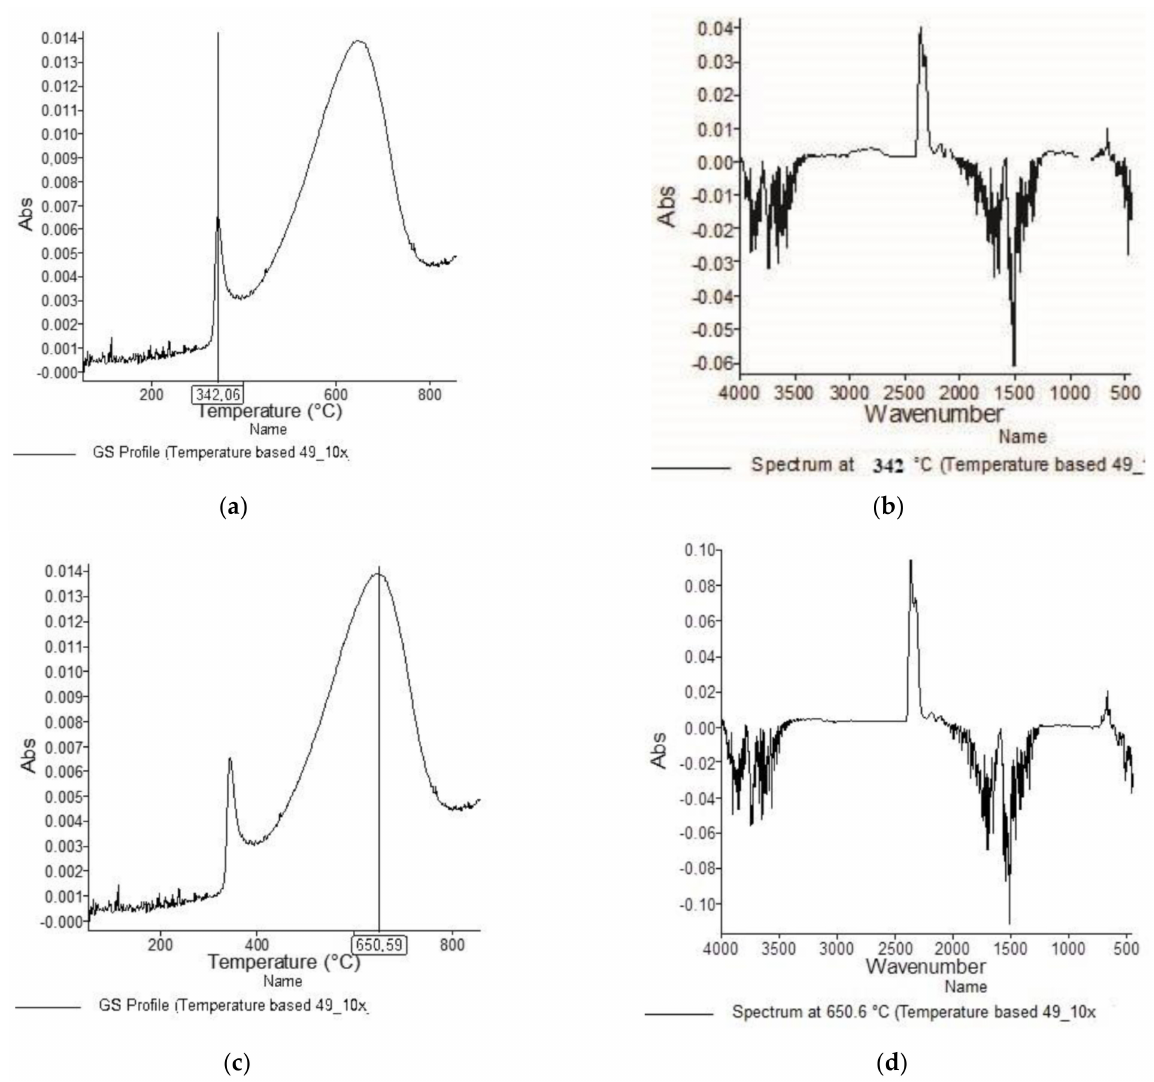
Figure 10. TG–IR analysis of 49_10x during thermo–oxidative decomposition: ( a ) and ( c ) intensity profile FT–IR spectrum of gas evolved, ( b ) FT–IR spectrum of gas evolved at 344.9 ◦ C, ( d ) FT–IR spectrum of gas evolved at 650.6 ◦ C.